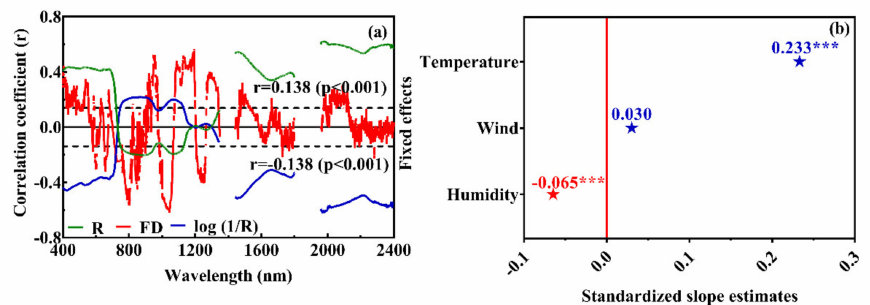
Figure 4. The correlation between rice plant potassium content (PKC) ( a ), reflectance spectra (R), first derivative spectra (FD), and reciprocal logarithm-transformed spectra (log (1/R)). Dotted horizontal lines illustrate significance level ( p value < 0.001). Standardized slope ( b* ) estimates for meteorological factors of the linear mixed effects model with PKC as the dependent variable and the following fixed effects: daily average temperature, average wind, and humidity. The symbol of *** represents statistical significance levels ( p < 0.001) ( b ). (For interpretation of the references to colour in this figure legend, the reader is referred to the web version of this article).